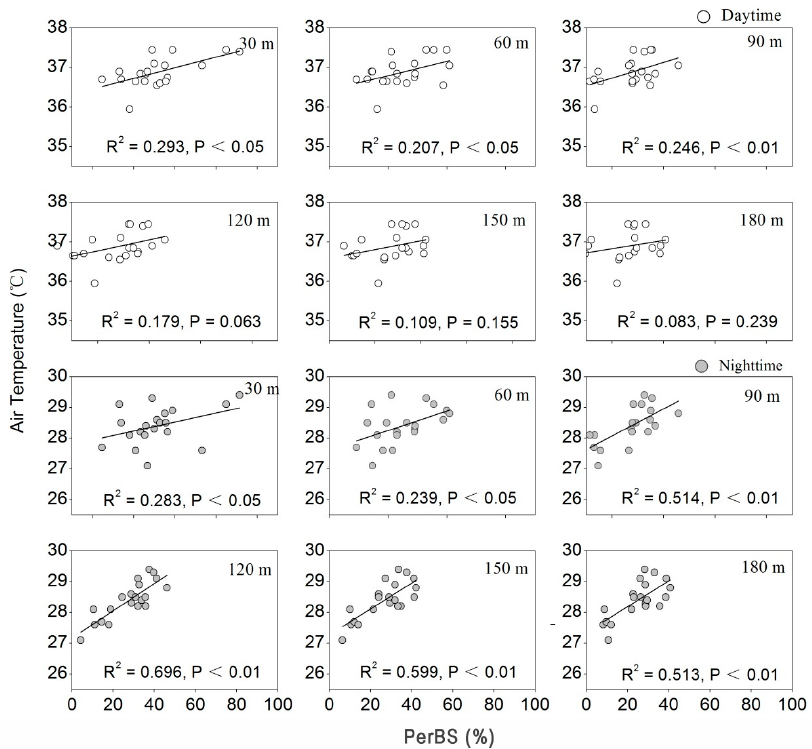
Figure 7. Relationships between air temperature and the percentage of building surface in different radii.